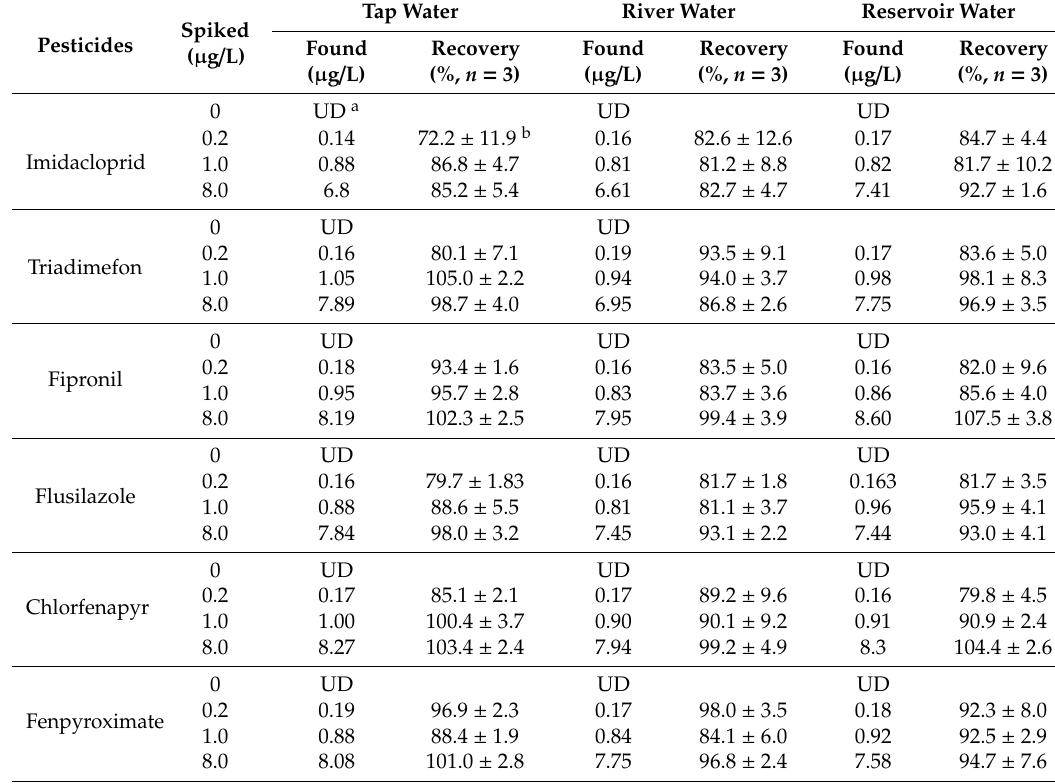
Figure 7. HPLC chromatograms of six heterocyclic pesticides in real reservoir water samples after MSPE without spiking ( a ) and with spiking ( b ). Peak identification: (1) Imidacloprid (2) triadimefon, (3) flusilazole, (4) fipronil, (5) chlorfenapyr, (6) fenpyroximate. Extraction conditions were the optimal condition. Table 3. Determination of six heterocyclic pesticides and method recoveries in real water samples.